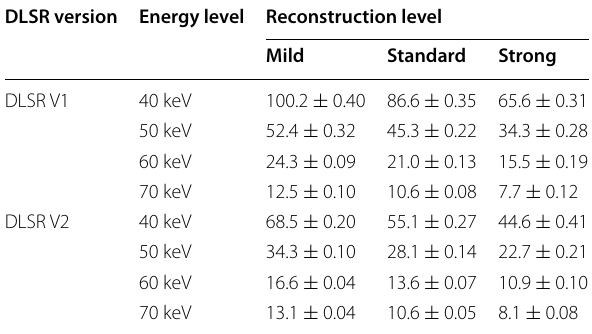
Table 1 Contrast values of the iodine insert obtained for the low energy levels on virtual monoenergetic images (VMIs) and with the three reconstruction levels of both versions of the deep learning spectral reconstruction (DLSR V1 and DLSR V2)